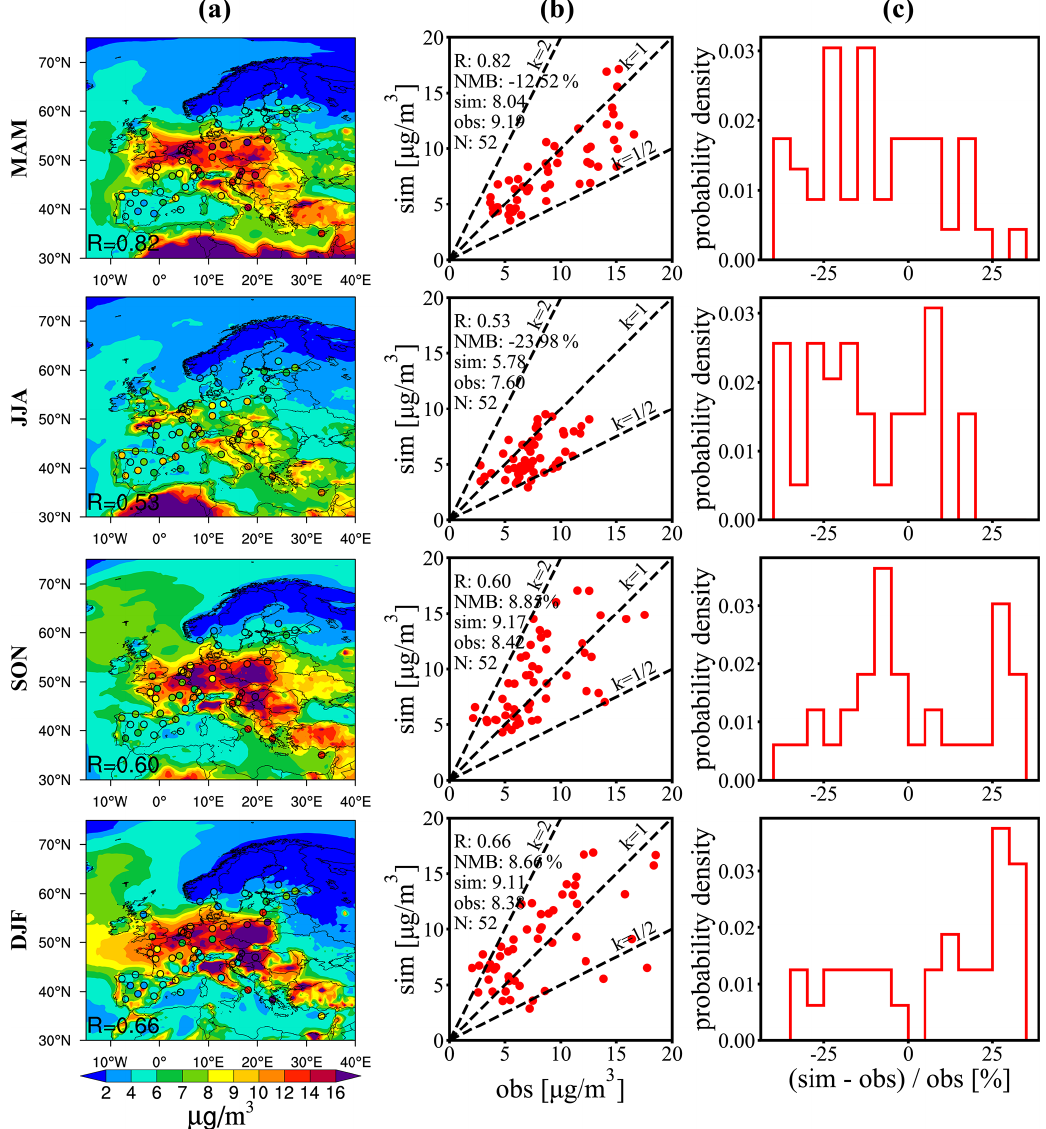
Figure 10. Same as Fig. 8 but in